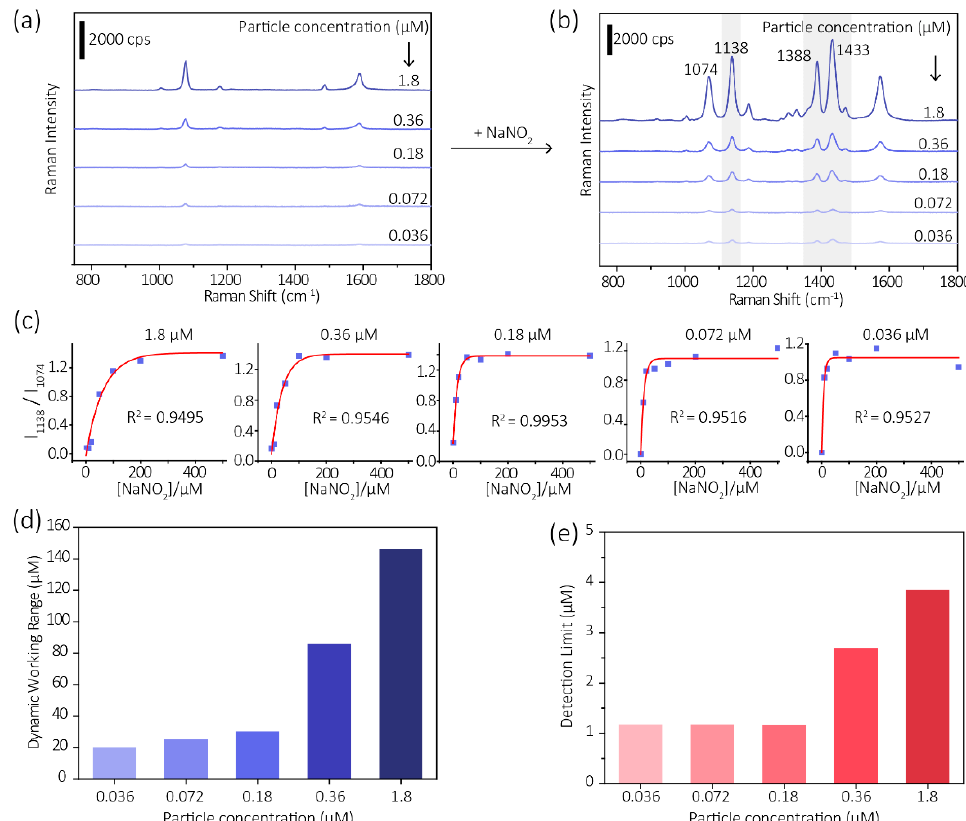
Figure 4. Influences of particle concentrations of GNP-PATP probe to the sensitivity of the assay. SERS spectra of GNP-PATP probe with different concentrations ( a ) before and ( b ) after addition of nitrite ions. ( c ) Normalized Raman peak intensity at ~1141 cm − 1 of the GNP-PATP probe to various nitrite concentrations, and the resulting ( d ) dynamic working range and ( e ) detection limits using different particle concentrations of GNP-PATP.